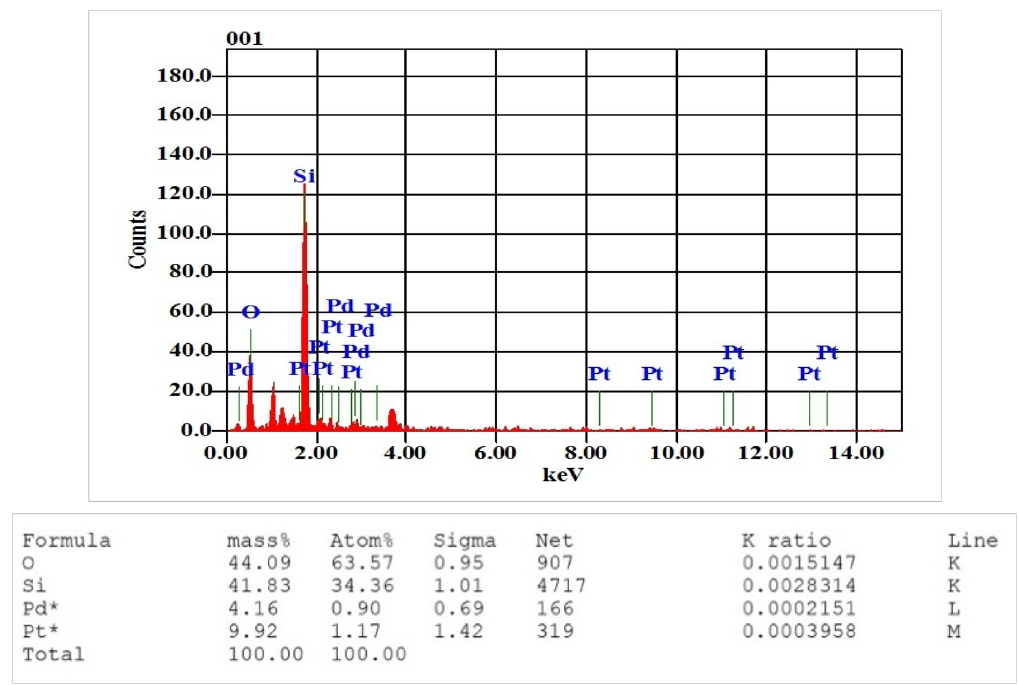
Figure 5. EDS spectrum of composite nanoparticles. The composite nanoparticles consist of palladium and platinum with mass percentage of 4.16% for palladium, and 9.92% for platinum. The existence of other elements such as silicon (Si), and Oxygen (O) is due to the glass substrate.